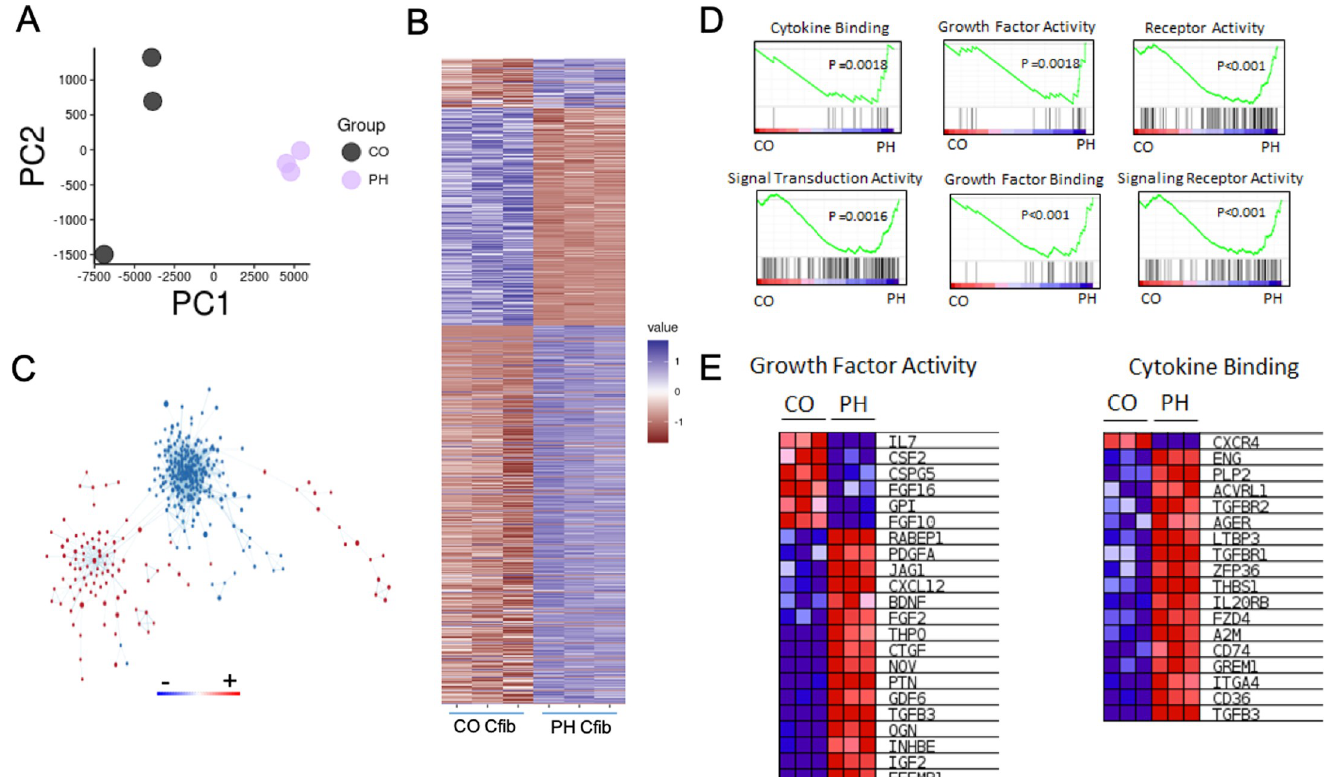
Fig 4. RNAseq analysis of control (CO) and pulmonary hypertension (PH) cardiac fibroblasts. A) PCA analysis of RNAseq data from CO and PH fibroblasts. B) Heatmap of gene expression comparing control fibroblasts to pulmonary hypertension fibroblasts. Genes with a significant difference of 0.05 > were selected. Expression values were scaled from -1 to 1, similarity was calculated using an euclidean distance and clustered using a centroid linkage k-means method. C) Network of transcriptional changes comparing CO and PH fibroblasts. We displayed differentially enriched pathways from GSEA as enrichment networks, in which each node is a pathway, and each link between nodes is a common gene. The size of the nodes indicates the number of genes found in our data that are in the pathway. Red coloring indicates pathways enriched in the PH group, whereas blue indicates pathways enriched in the CO group. The CO and PH networks are independent, suggesting significant divergence of in the signaling cascades between these two groups of cells. D) Select enrichment plots highlighting the enriched pathways identified by GSEA. E) Two representative heatmaps for the Growth Factor Activity and Cytokine Binding pathways showing the genes responsible for the